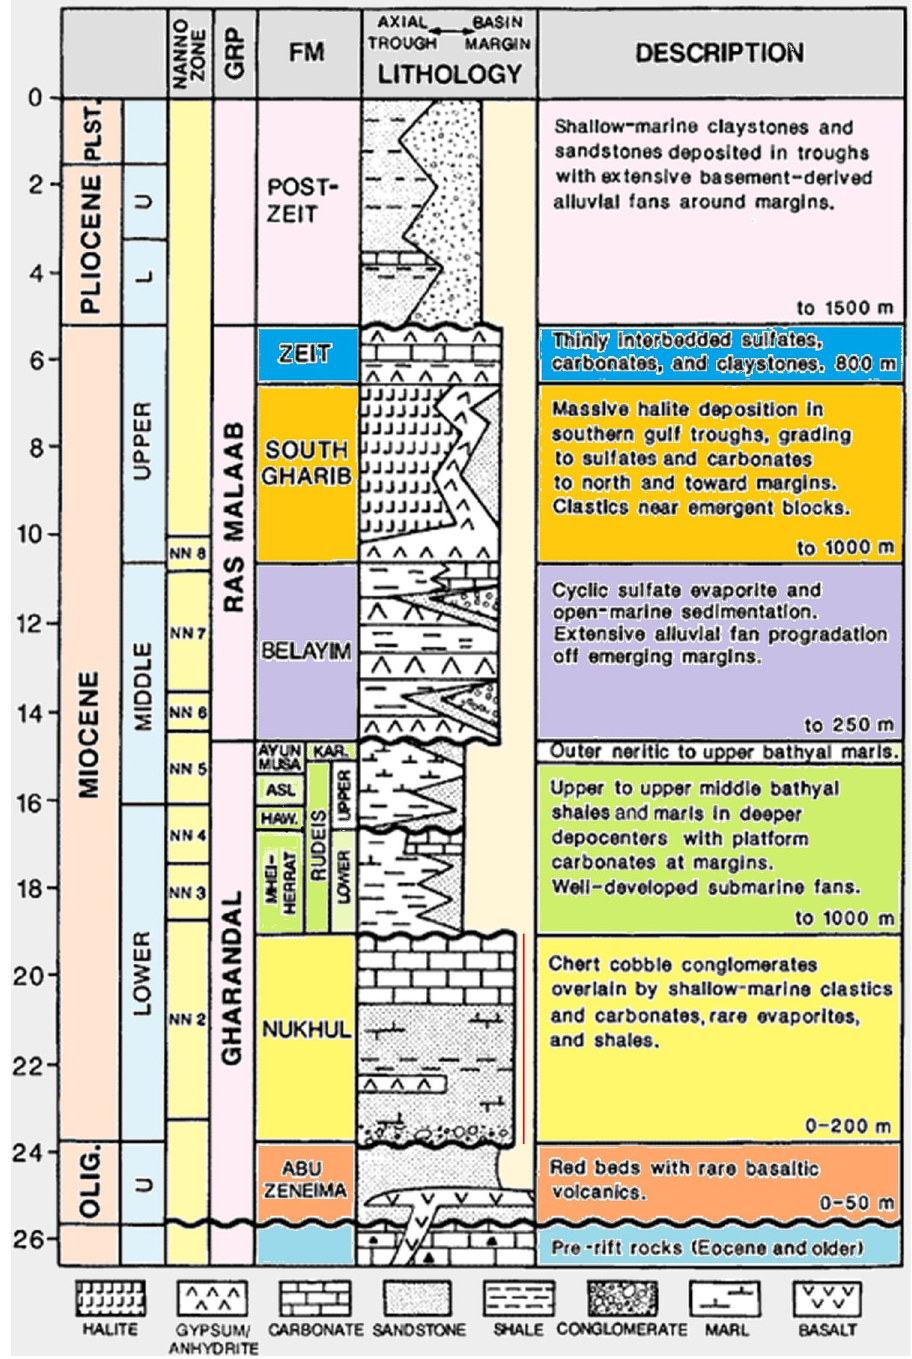
Fig. 2 Stratigraphic column of Gulf of Suez, with calcareous nanoplankton zonation and absolute ages with formational nomenclature of Hosny et al. (1987) (modefied from